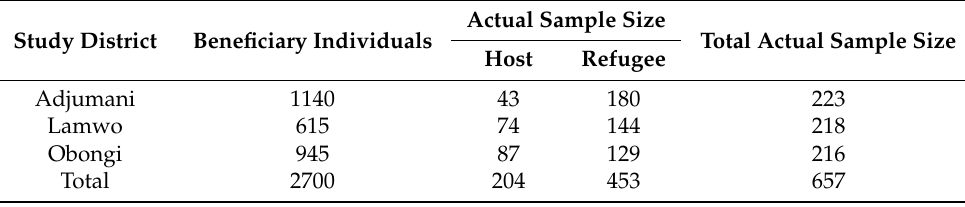
Actual Sample Size Total Actual Sample Size Host Refugee